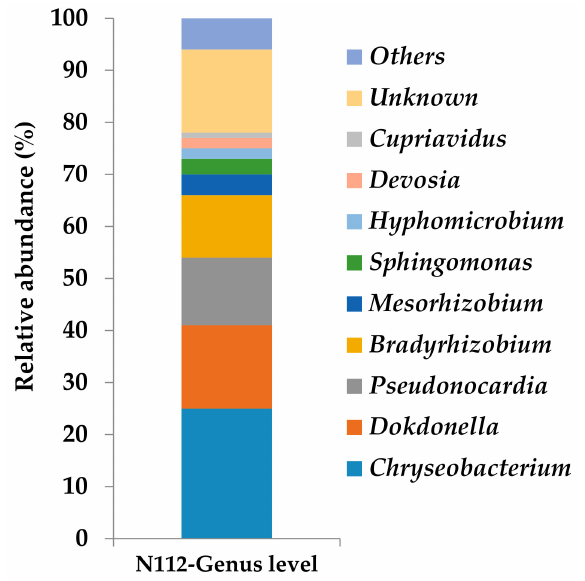
Figure 7. Relative abundance of bacteria at the genus level in the microbial consortium N112 (27th